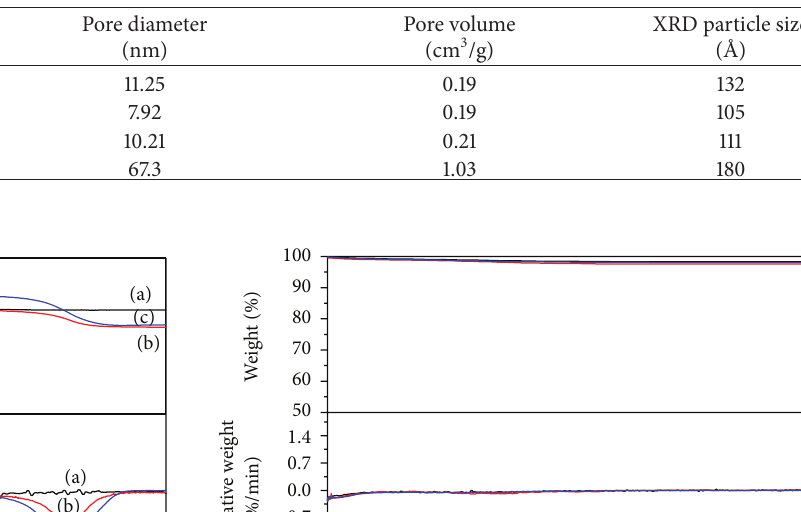
and synthesized TiO 2